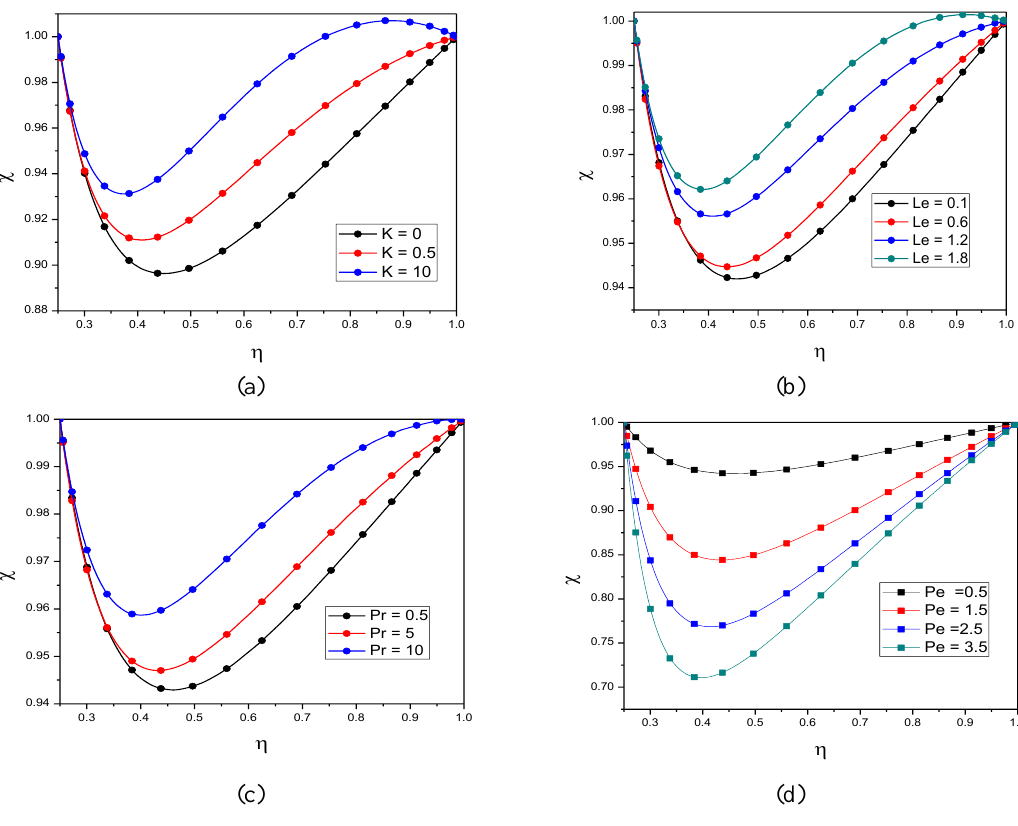
Figure 2. Profiles of 𝜒 w.r.t the parameter chemical reaction parameter ( K ), Lewis number ( 𝐿𝑒 ), Prandtl number ( 𝑃𝑟 ), bioconvection Peclet number ( 𝑃𝑒